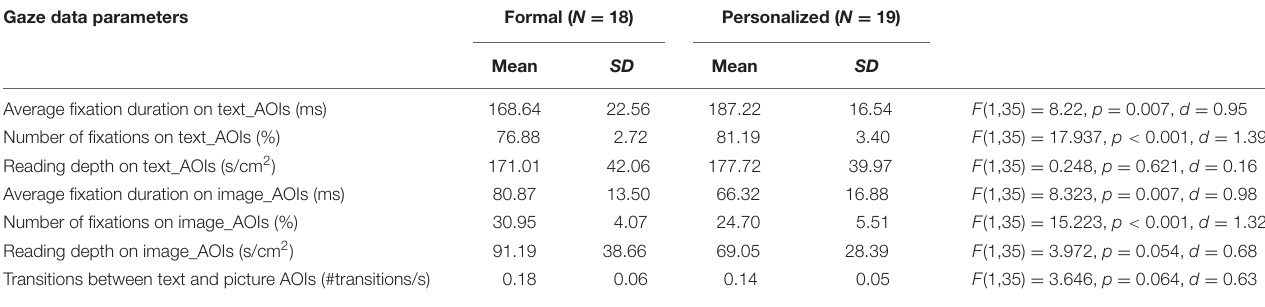
TABLE 3 | Means, standard deviations and between-subject effects for gaze data variables for both conditions (Hypothesis 2.1 and 2.2). Gaze data